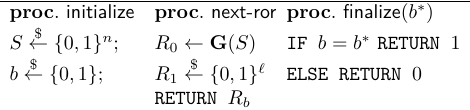
Figure 1: Procedures in Security Game